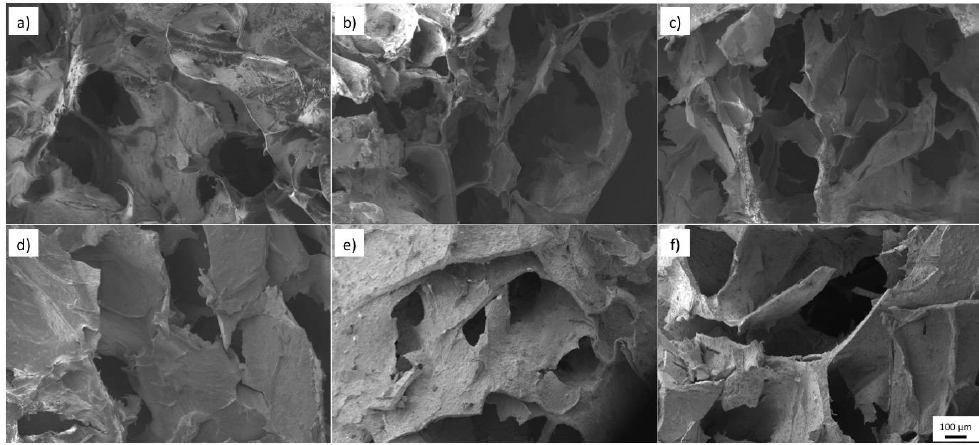
Figure 5. SEM morphology of hydrogels ( a ) HG-1 ( b ) HG-2 ( c ) HG-3 ( d ) HG-4 ( e ) HG-5 ( f ) HG-6.